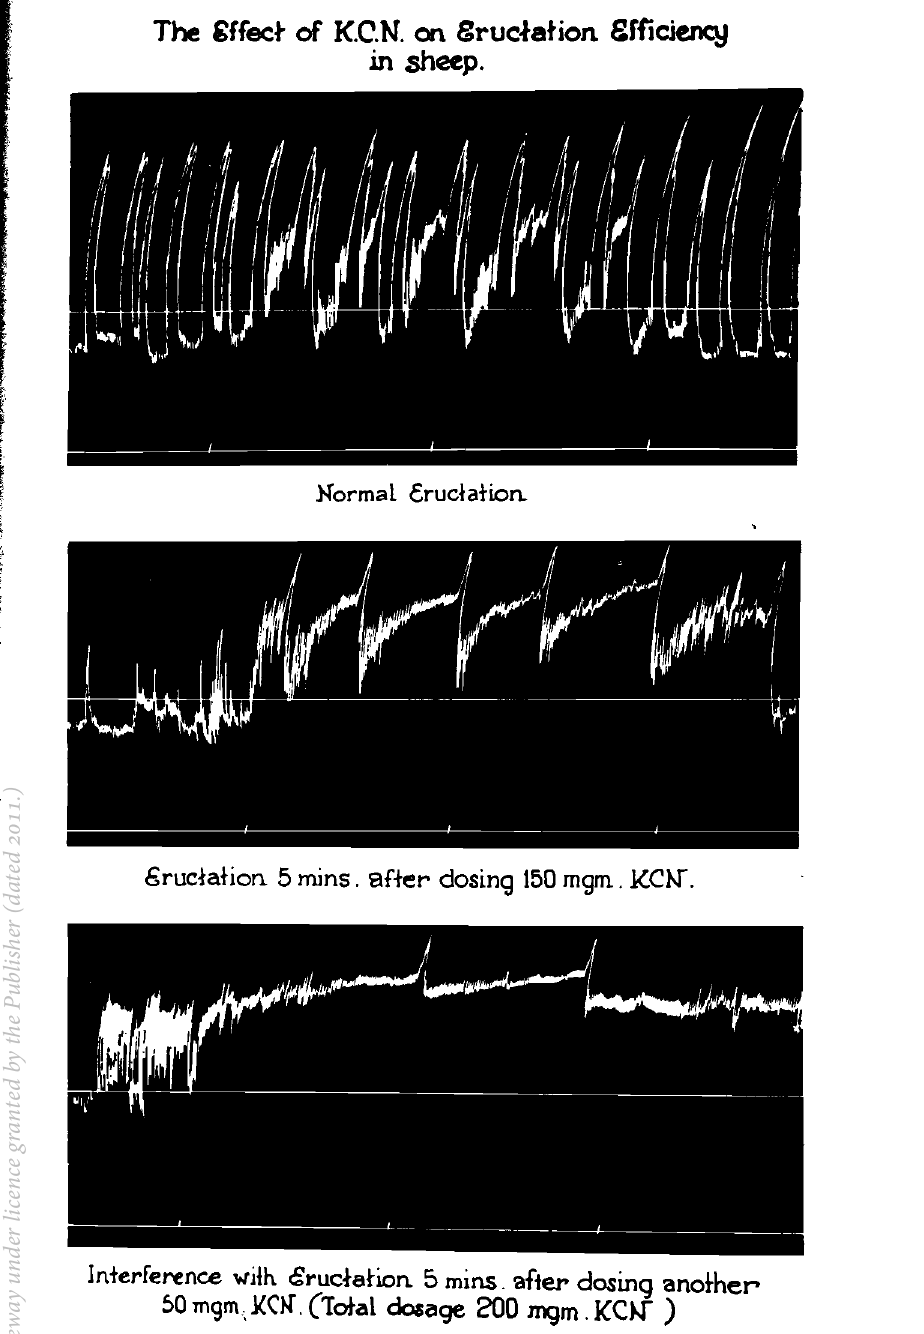
Interference with erudation ;; mins. after dosing another 50 mgm)(Or. (ToI-a1 doaage 200 mgm .I(C)..f ) THE EFFECT OF POTASSIUM CYANIDE ON THE ERUCTATION EFFICIENCY OF SHEEP Air was introduced into the rumen throughout all three tracings. In the centre tracing note the inefficiency of eructation due to reticular paralysis. In the bottom tracing there is almost complete ruminal paralysis, the pressure changes on the left being due to dyspnoea caused by the prussic acid. (Weiss, 1953)